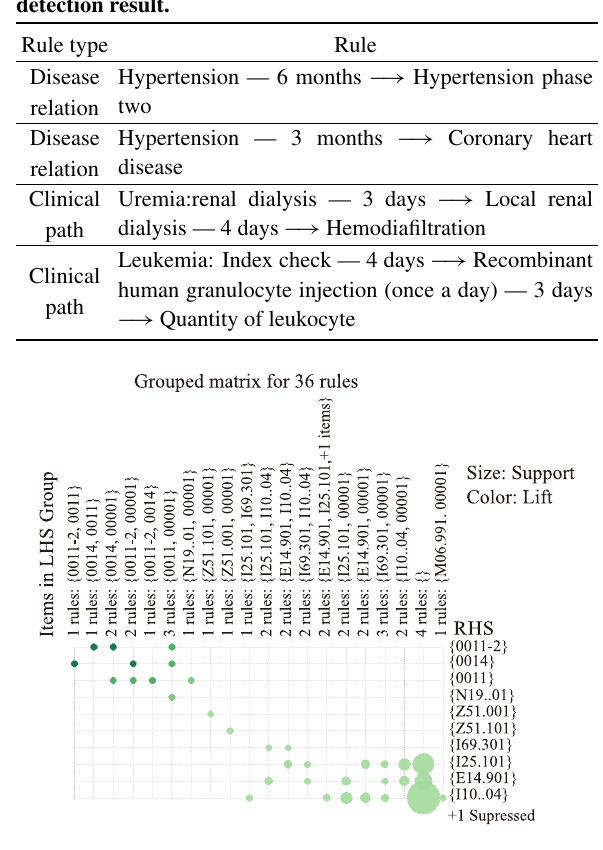
Fig. 7 Rules mined from the conventional Apriori algorithm. All of the orphan diseases are deleted in the first step and do not appear in the mined